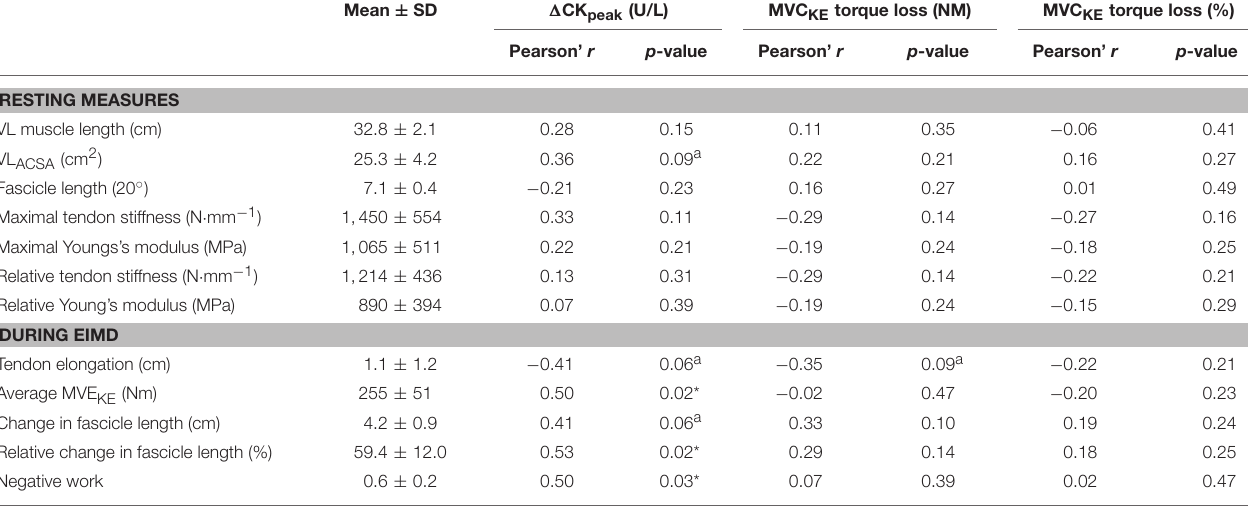
TABLE 1 | Correlations between VL and patella tendon properties during rest and EIMD with 1 CK peak and absolute and relative MVC KE torque loss.